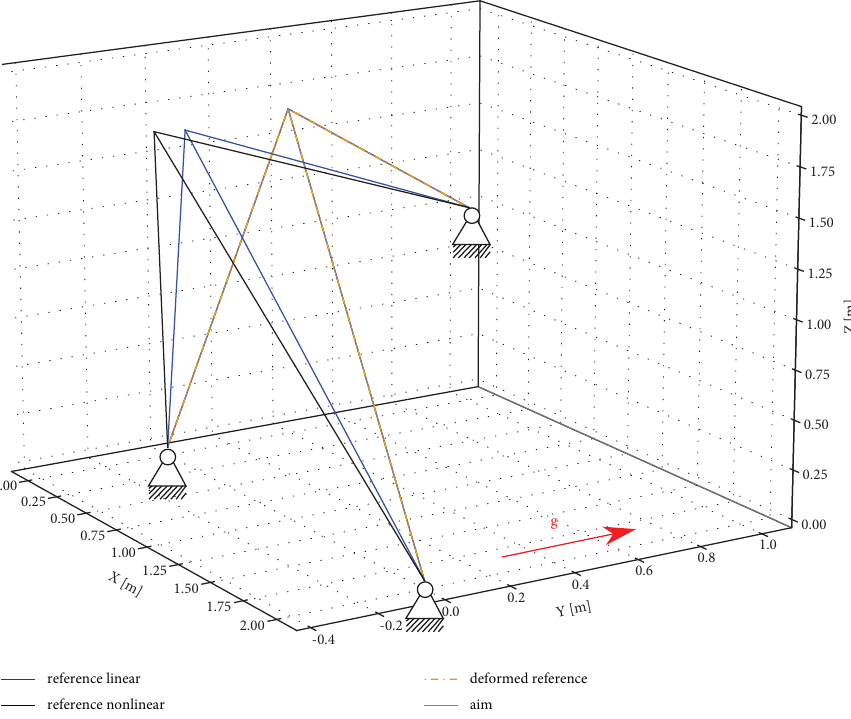
Figure 19: Unknown and known confguration of a three-dimensional truss structure, subjected to self-weight. Te red arrow indicates the normalized gravity direction vector g , acting in the y -direction. Table 4: Solution of the initially unknown confguration and aim confguration of the 3-bar structure in Figure 19 with linear truss elements. X Y